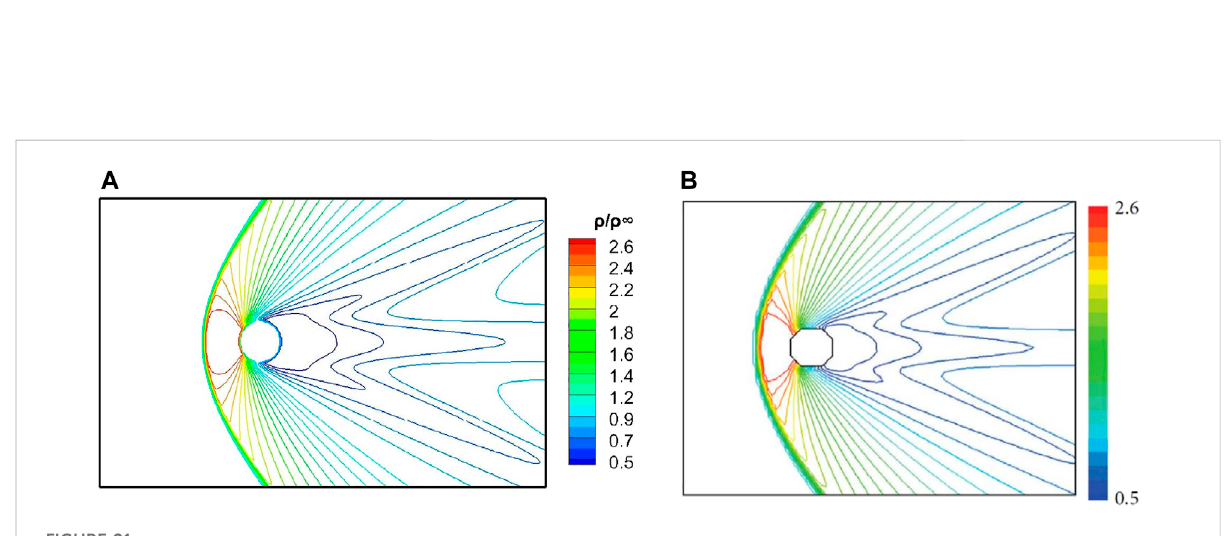
streamlines are shown in a zoomed-in view of the region near the trailing edge to compare the predictions of the recirculation zone between the present IBM and body- fi tted simulation by Swanson and Langer (2016). It can be observed that the location and size of the recirculation regions look very similar. Furthermore, the errors in the lift coef fi cient c l and the drag coef fi cient c d , between the present computation and value reported by Swanson and Langer (2016) using body- fi tted grid simulations, are determined to be about 1.07% and 2.6%,